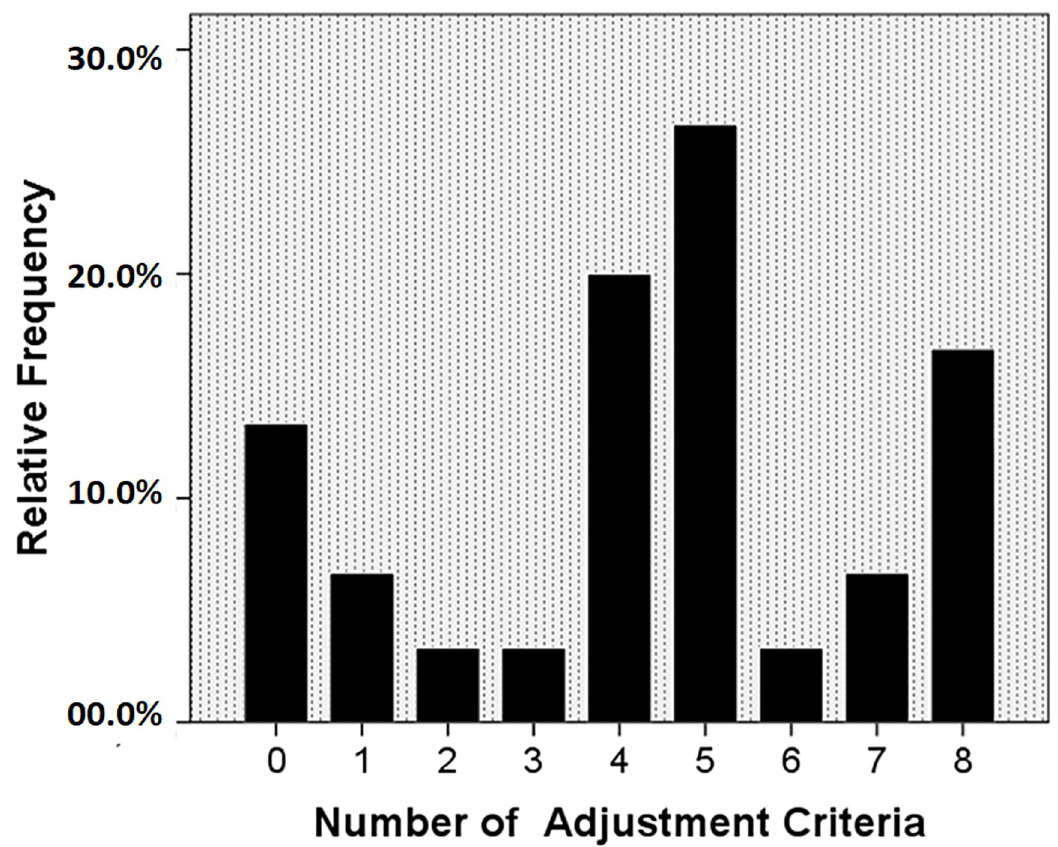
Fig 2. Bar chart with the number of adjustment criteria used in the Latent Class Analysis (LCA) to evaluate the adolescents’ lifestyle.